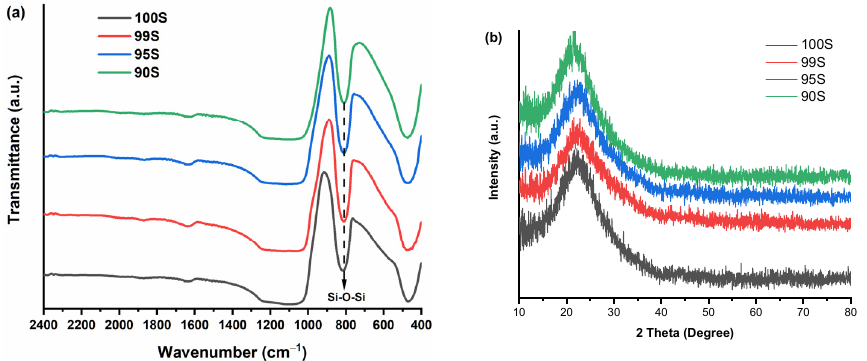
Figure 4. ( a ) Fourier transform infrared spectroscopy (FTIR) spectra and ( b ) X-ray diffraction (XRD) patterns of 100S, 99S, 95S, and 90S.